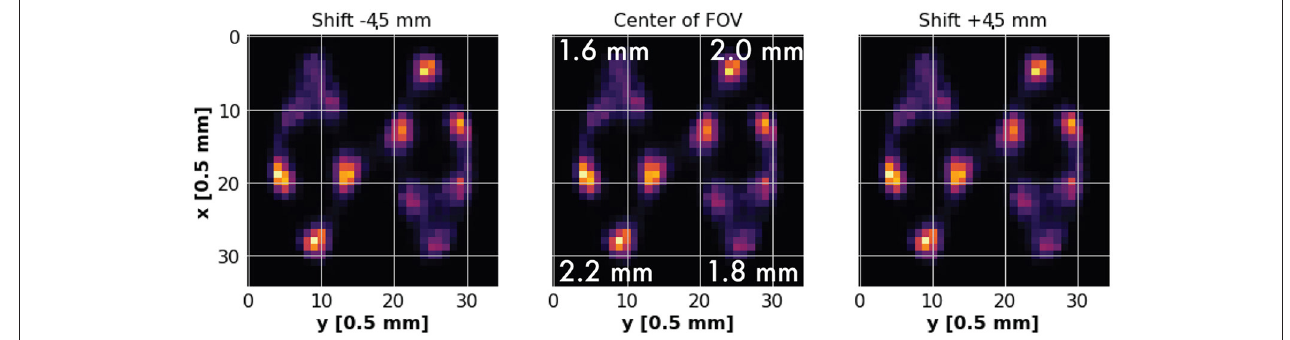
4.5 mm along the transverse axis of ±